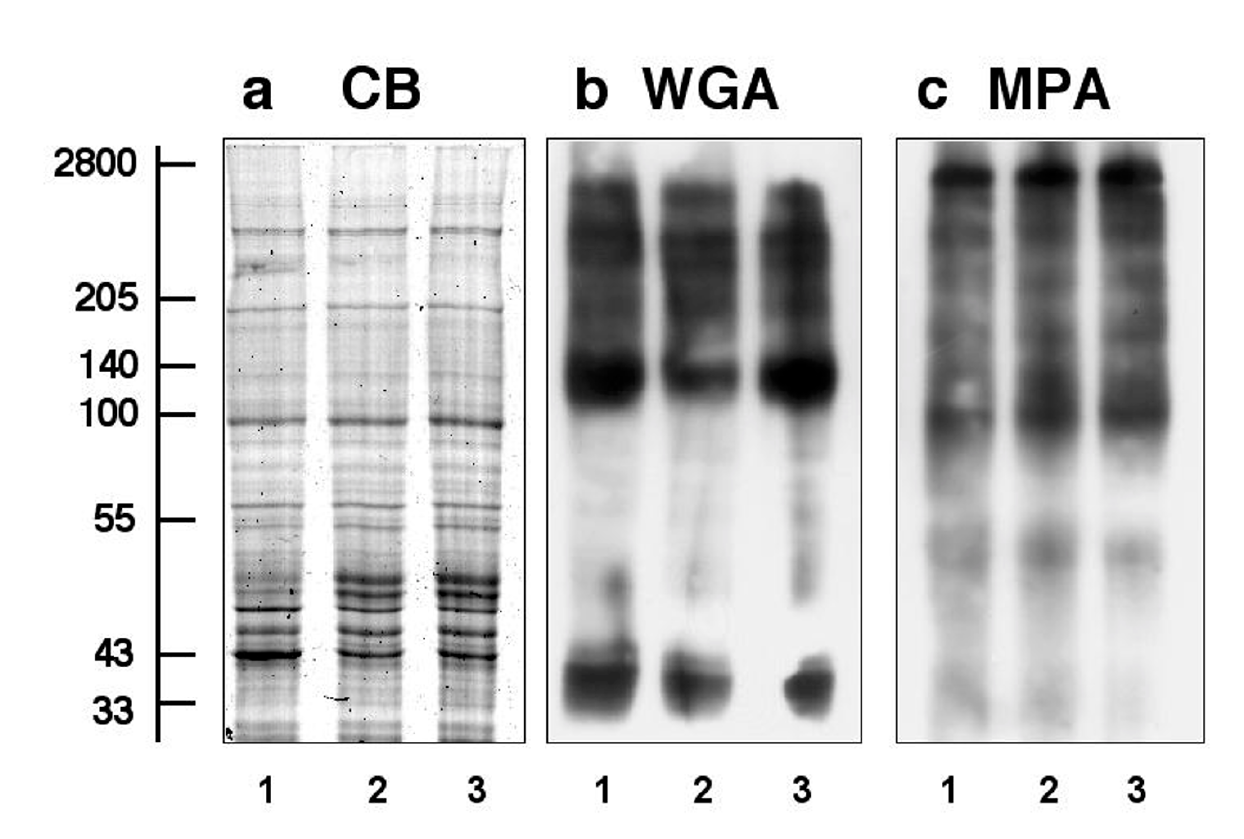
Figure 6 Analysis of microsomal preparations from normal, mdx and mdx -3cv brain. Shown is a Coomassie-stained gel (CB) (a) and identical blots labeled with the Tritium vulgaris lectin WGA (b) and the Maclura pomifera lectin MPA (c). Lanes 1 to 3 represent microsomal membranes isolated from normal brain, mdx brain, and mdx -3cv brain, respectively. The relative position of molecular mass standards ( × 10 -3 ) is indicated on the